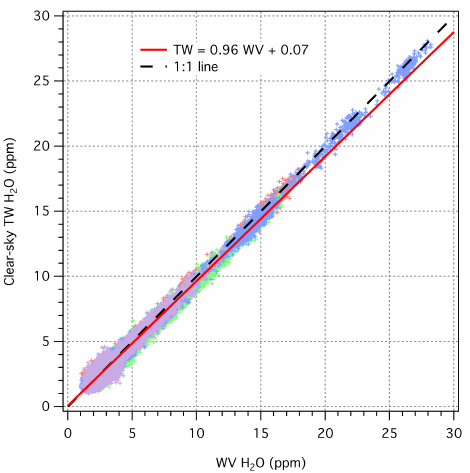
Figure 13. Correlation of H 2 O measured in the TW channel with that measured in the WV channel for cloud-free sampling condi- tions during ATTREX 2013 flights. The slope of the correlation calculated using linear orthogonal distance regression was 0.96. In- dividual flight correlation slopes ranged from 0.95 to 0.98 and the r 2 values of the correlations ranged from 0.92 to